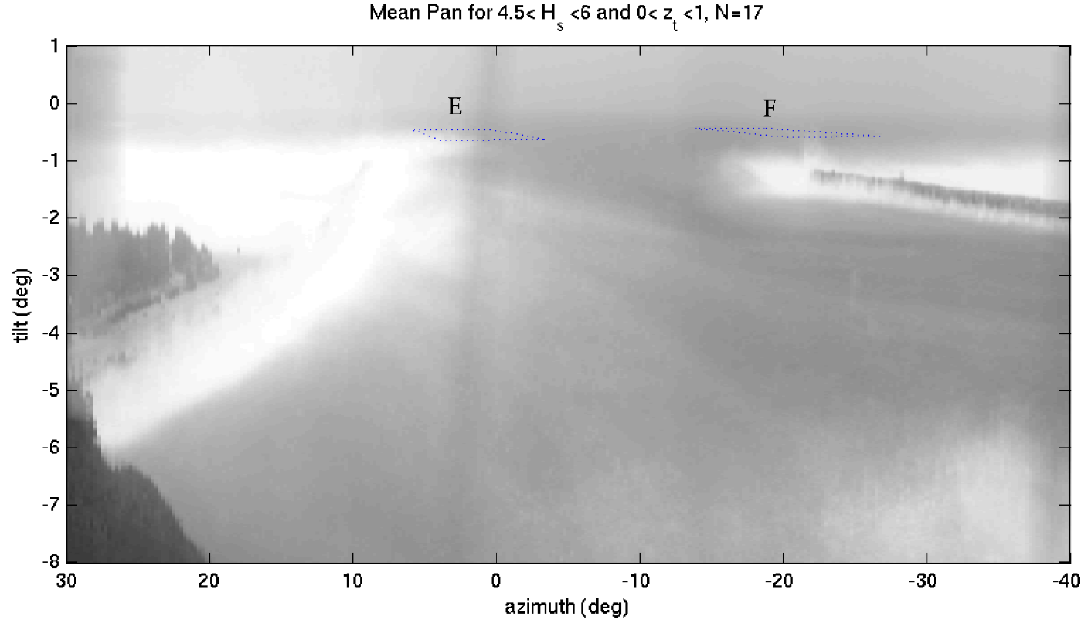
Figure 12. Bin-averaged “brightest” pan for wave heights greater than 4.5 m and mid to high tides. A total of 17 individual pans were included in this average. The E and F dredge disposal sites are shown with dotted lines.